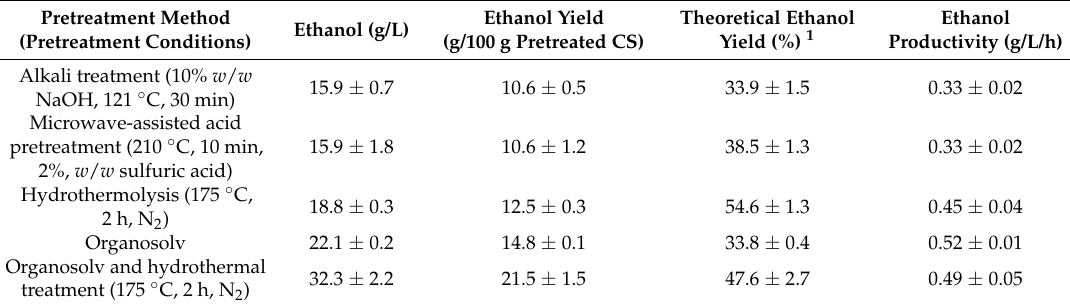
Table 2. Ethanol production from pretreated CS in relation to pretreatment